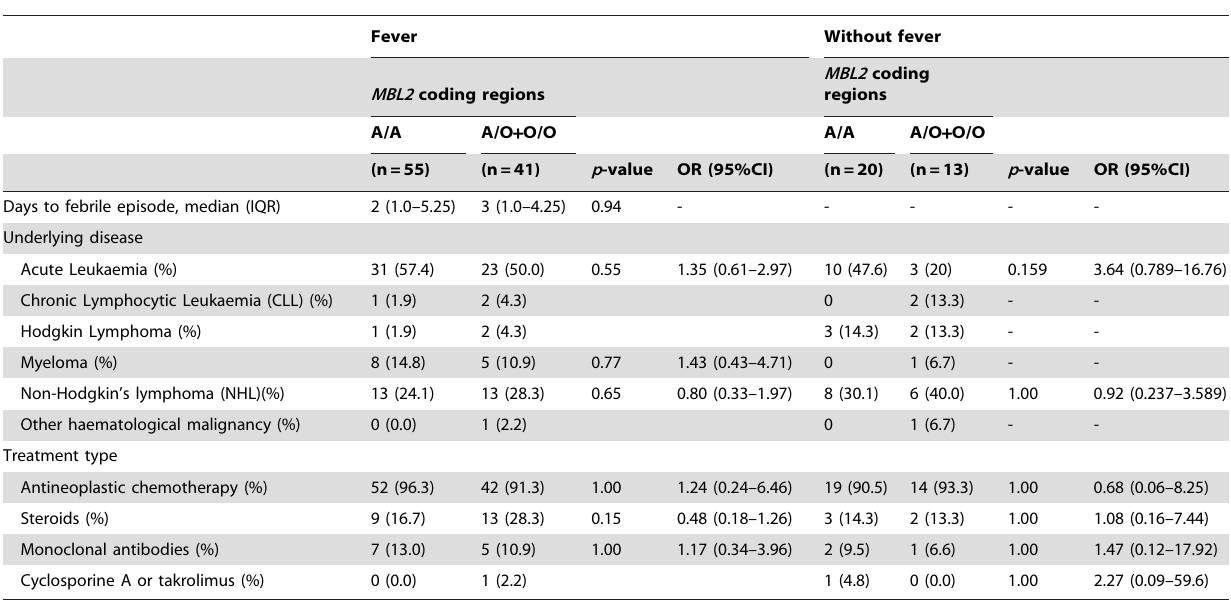
Table 1. General characteristics of febrile and afebrile neutropaenic